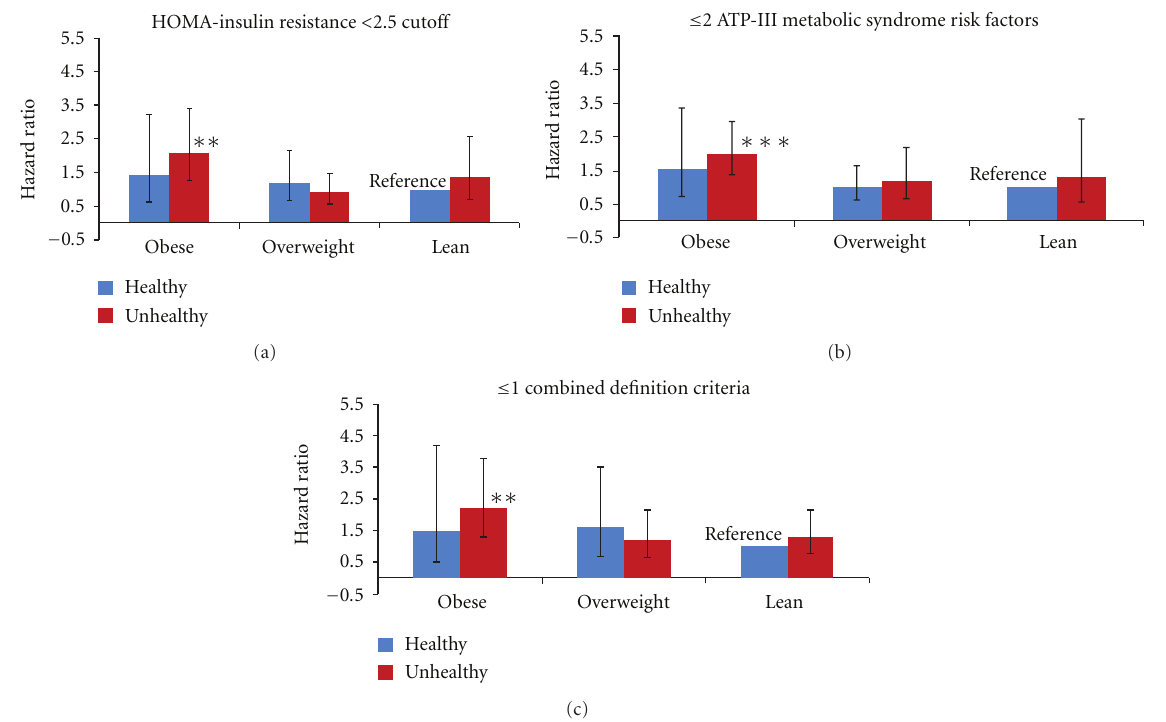
Figure 2: Risk of Mortality Associated with Metabolic Health and Body Mass Index (BMI) by Three Definitions. Error bars represent 95% confidence intervals of hazard ratios. ∗∗∗ Significant di ff erence from reference group (lean healthy) at P ≤ 0 . 001; ∗∗ significant di ff erence from reference group (lean healthy) at P ≤ 0 . 01; data analyzed using Cox Survival Analysis, adjusting for sex, age, income, education, race/ethnicity, smoking status, alcohol consumption, marital status, leisure time physical activity, and menopausal status. For description of definitions of metabolic health, see Table 1. HOMA-IR, homeostasis model assessment-insulin resistance; ATP-III, Adult Treatment